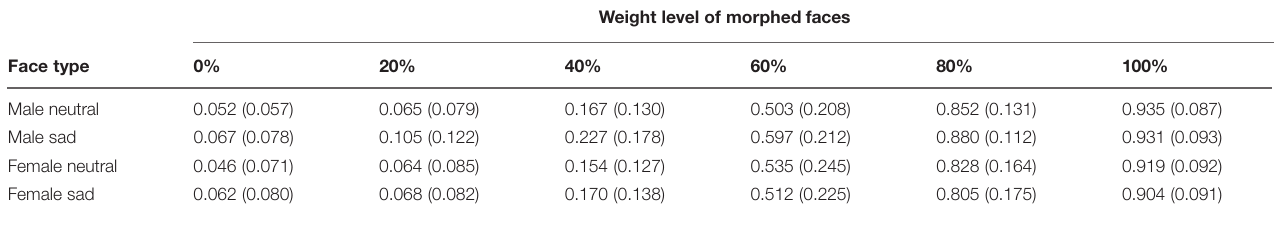
TABLE 1 | Mean and SD of the proportion of fat